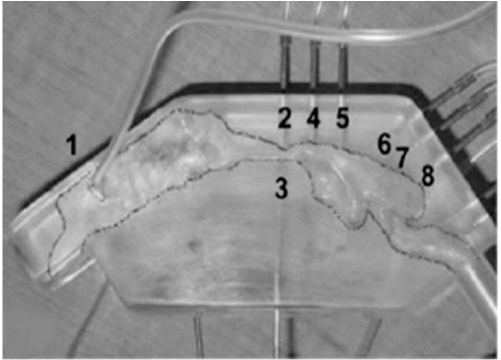
Figure 9. 85% scaled silicon cast UA model. Reprinted with permission from Ref. [51] . 2006, Chun Xu et al.